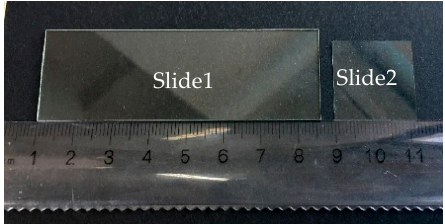
Figure 12. Picture of the transparent glass slides.